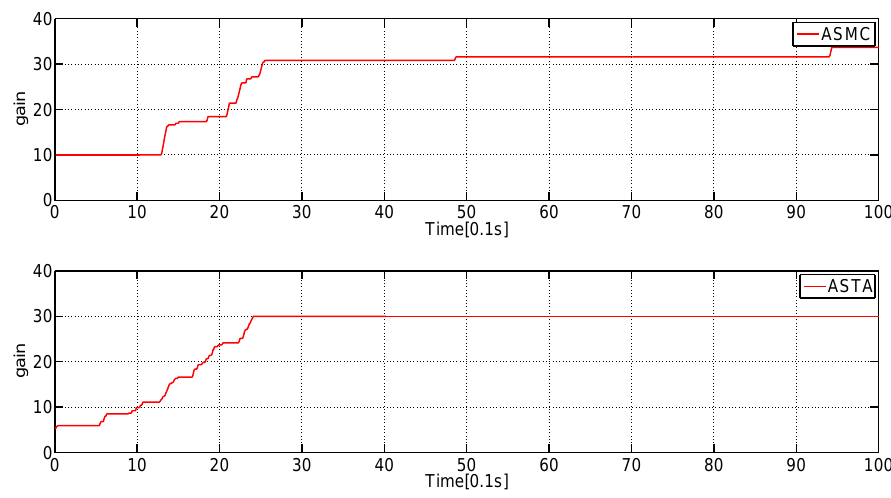
Figure 6. Comparison of the adaptive gains in Case 1.